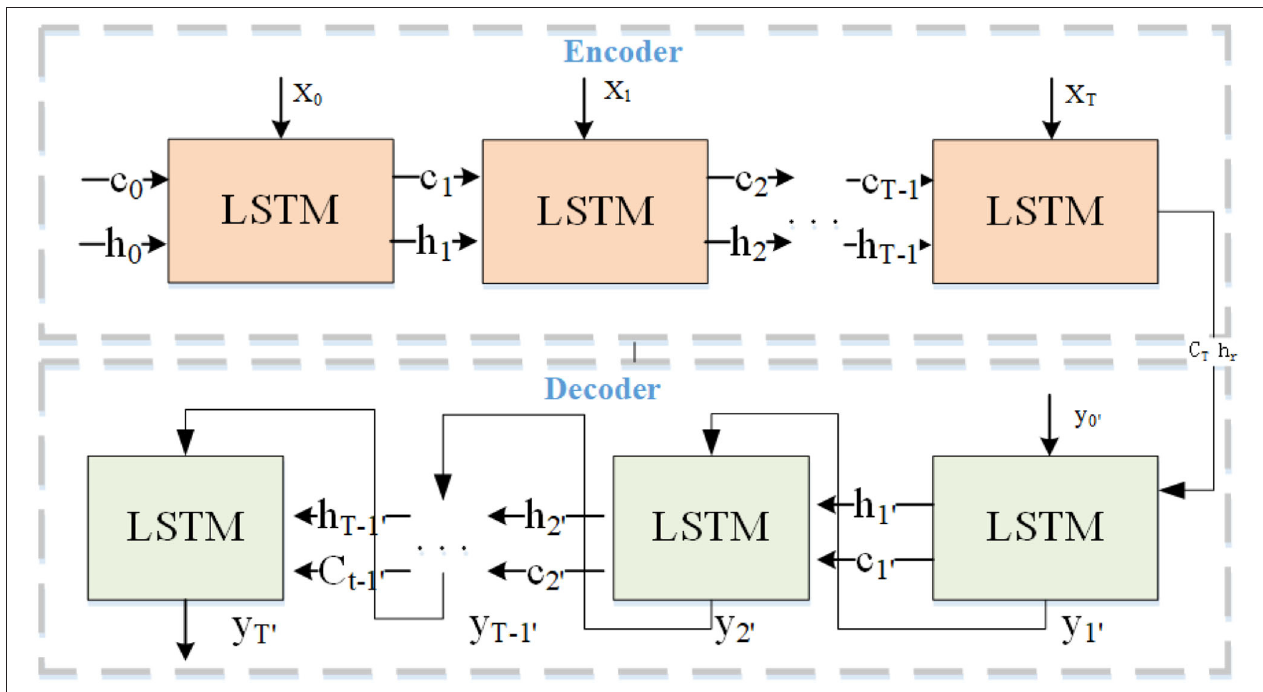
FIGURE 2 | Long-Short Term Memory (LSTM) encoder-decoder